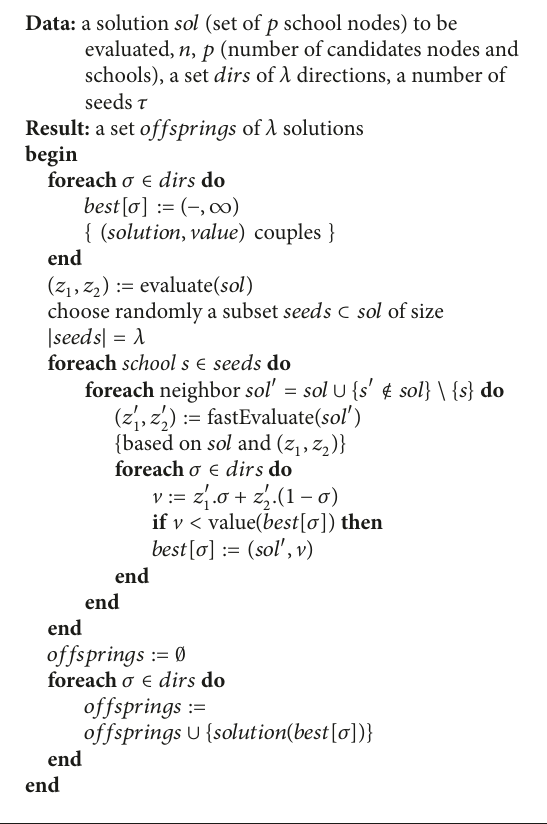
Algorithm 2: A local search method for supported solutions in 𝜆